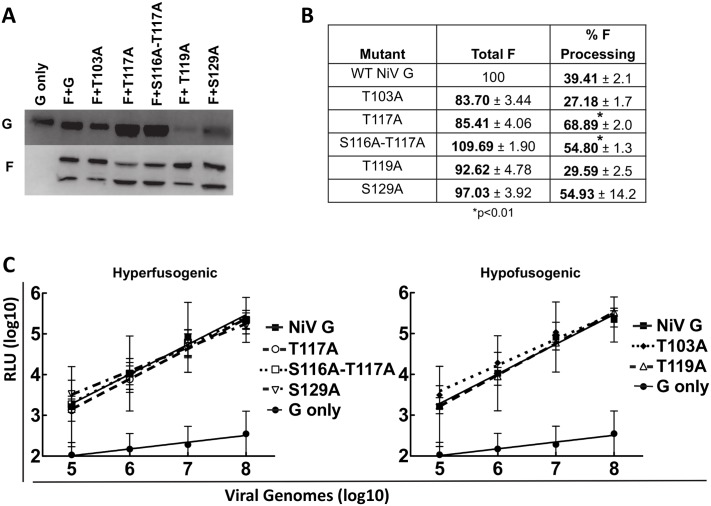
Loss of O-glycans in NiV G does not affect NiV F incorporation in pseudotyped virions, but affects NiV F processing and pseudotyped viral entry.A) Western blot of NiV/VSV viral lysates. NiV G (top panel) and NiV F (bottom panel) were detected as described in Fig 2. B) F incorporation and F processing of the NiV mutant pseudotyped virions determined by densitometry. F incorporation values were normalized to those of wt NiV. F processing was measured by the ratio of F1/ (F0+F1) for NiV pseudotyped virions. N = 3. Statistically significant differences, as determined by a Student's t-test, are marked with an * (p<0.01). C) Viral entry of NiV/VSV virions at log dilutions of viral input. Values for the mutant virions are compared to wt NiV values. Pseudotyped virions expressing only NiV G (no NiV F) were used as a negative control. Averages and standard deviations are shown. N = 3.